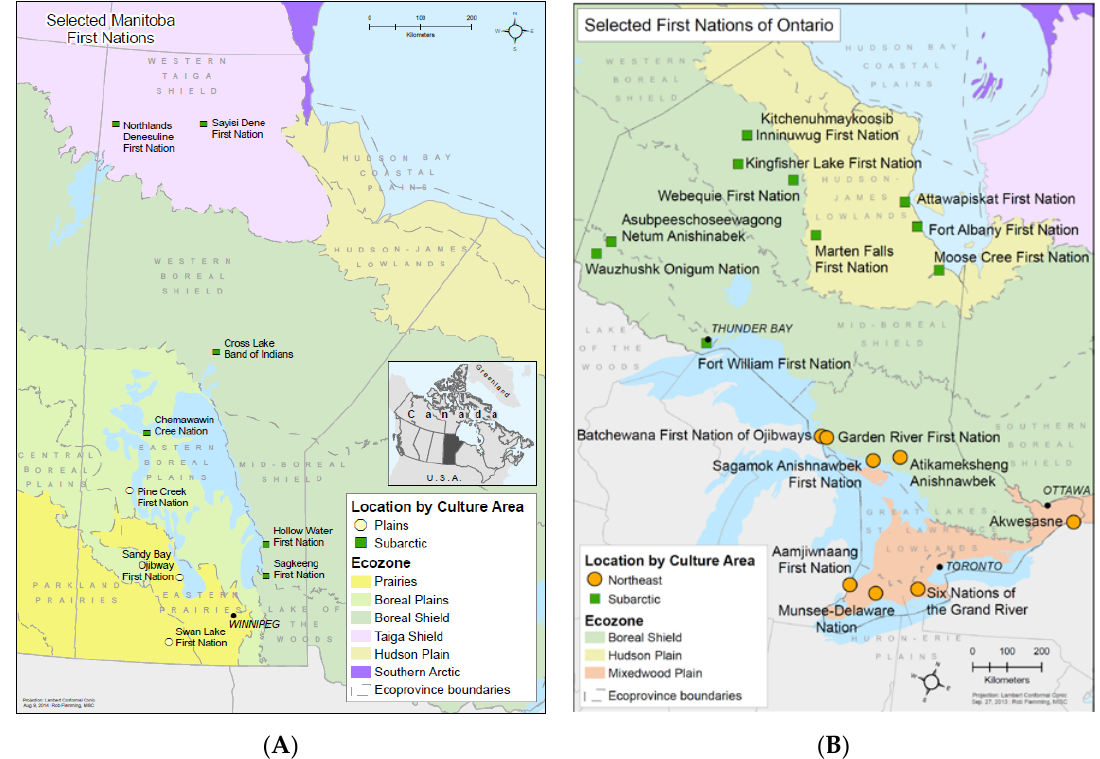
Figure 1. Map of participating First Nations communities in Manitoba ( A ) and Ontario ( B ) [38,39].